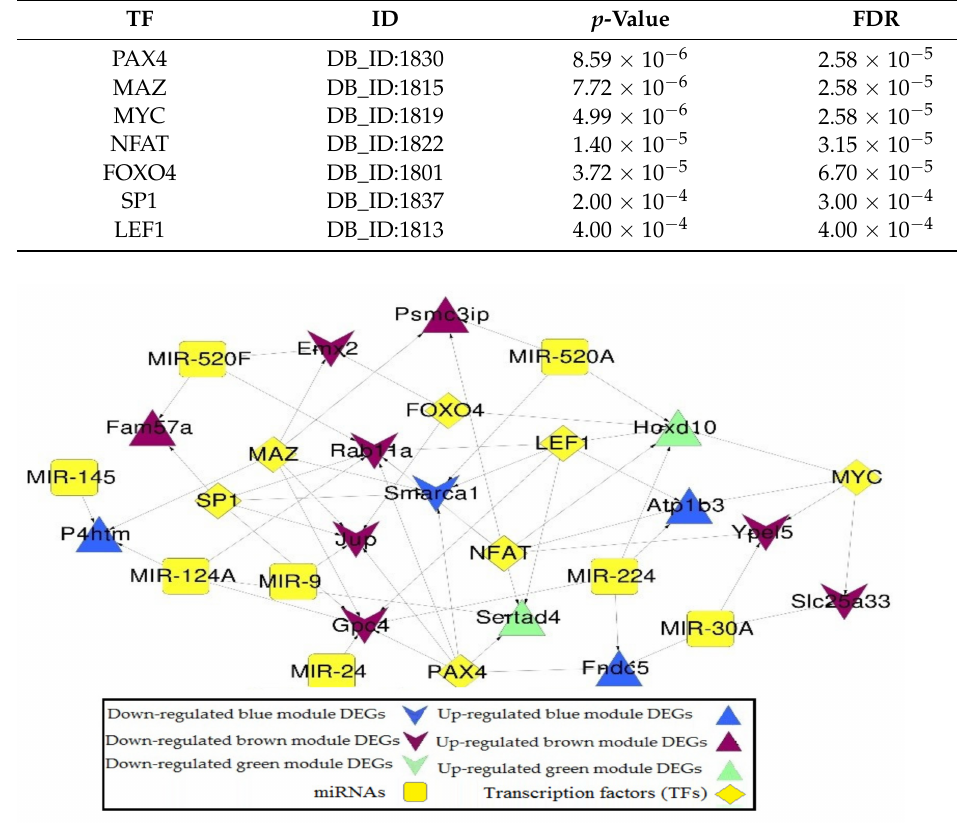
Table 5. Related TFs list.